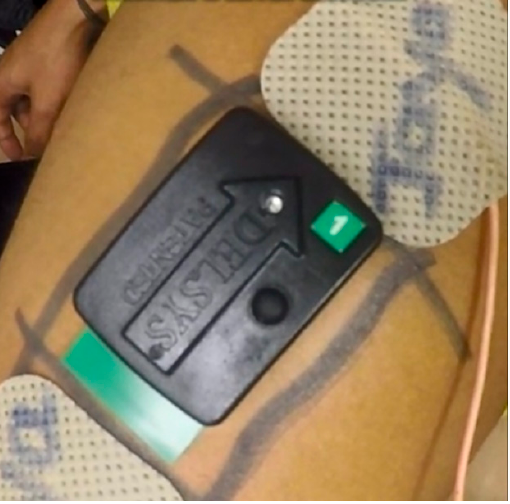
Figure 3. Illustration of region of interest (RoI) containing EMG sensor attached to the